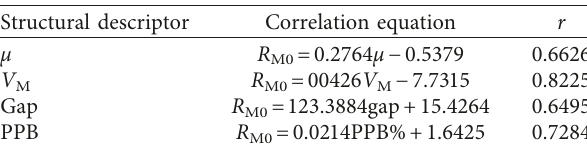
Table 7: Correlation of the R M0 parameter with physicochemical properties (dipole moment μ , volume of molecule V M , and HOMO-LUMO energy difference (gap)) and PPB for derivatives 1 – 11 , p < 0 .